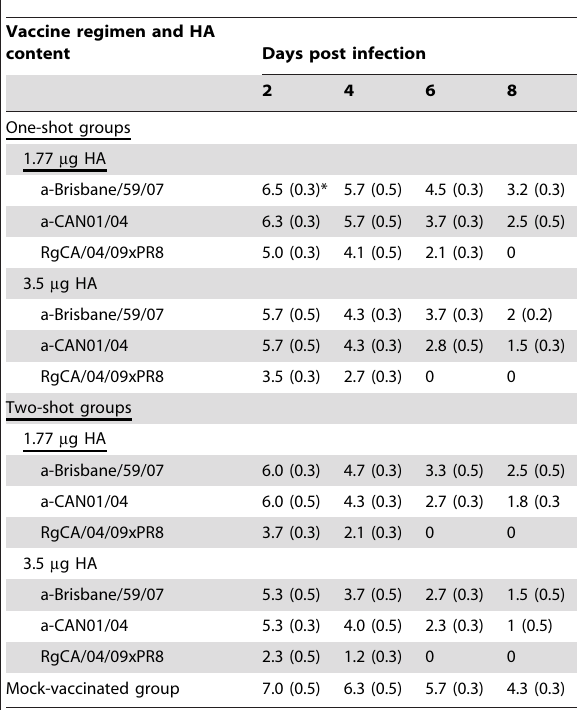
administration with inactivated